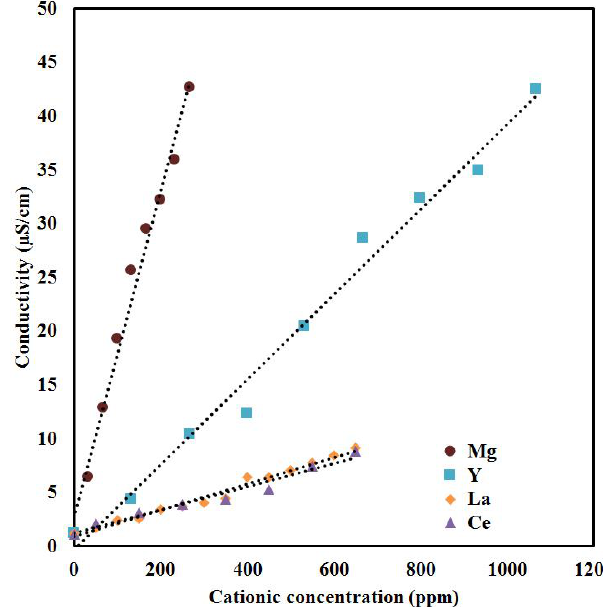
Fig. 2. Conductivity of ethanol by adding cations separately. Lanthanum concentration (♦), Yttrium concentration (■), Cerium concentration (▲) and Magnesium concentration